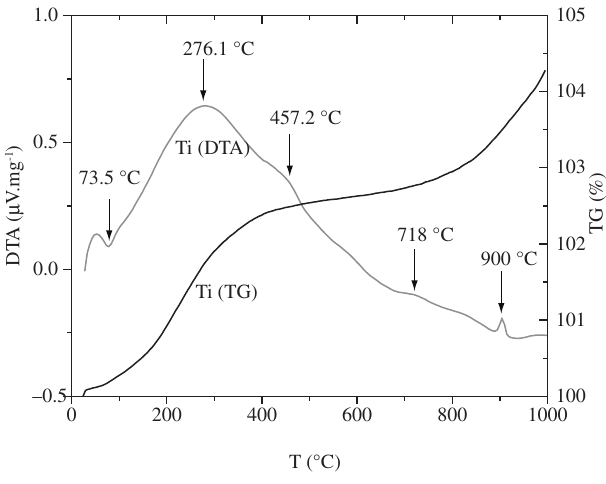
Figure 2. TG and DTA curves of titanium.